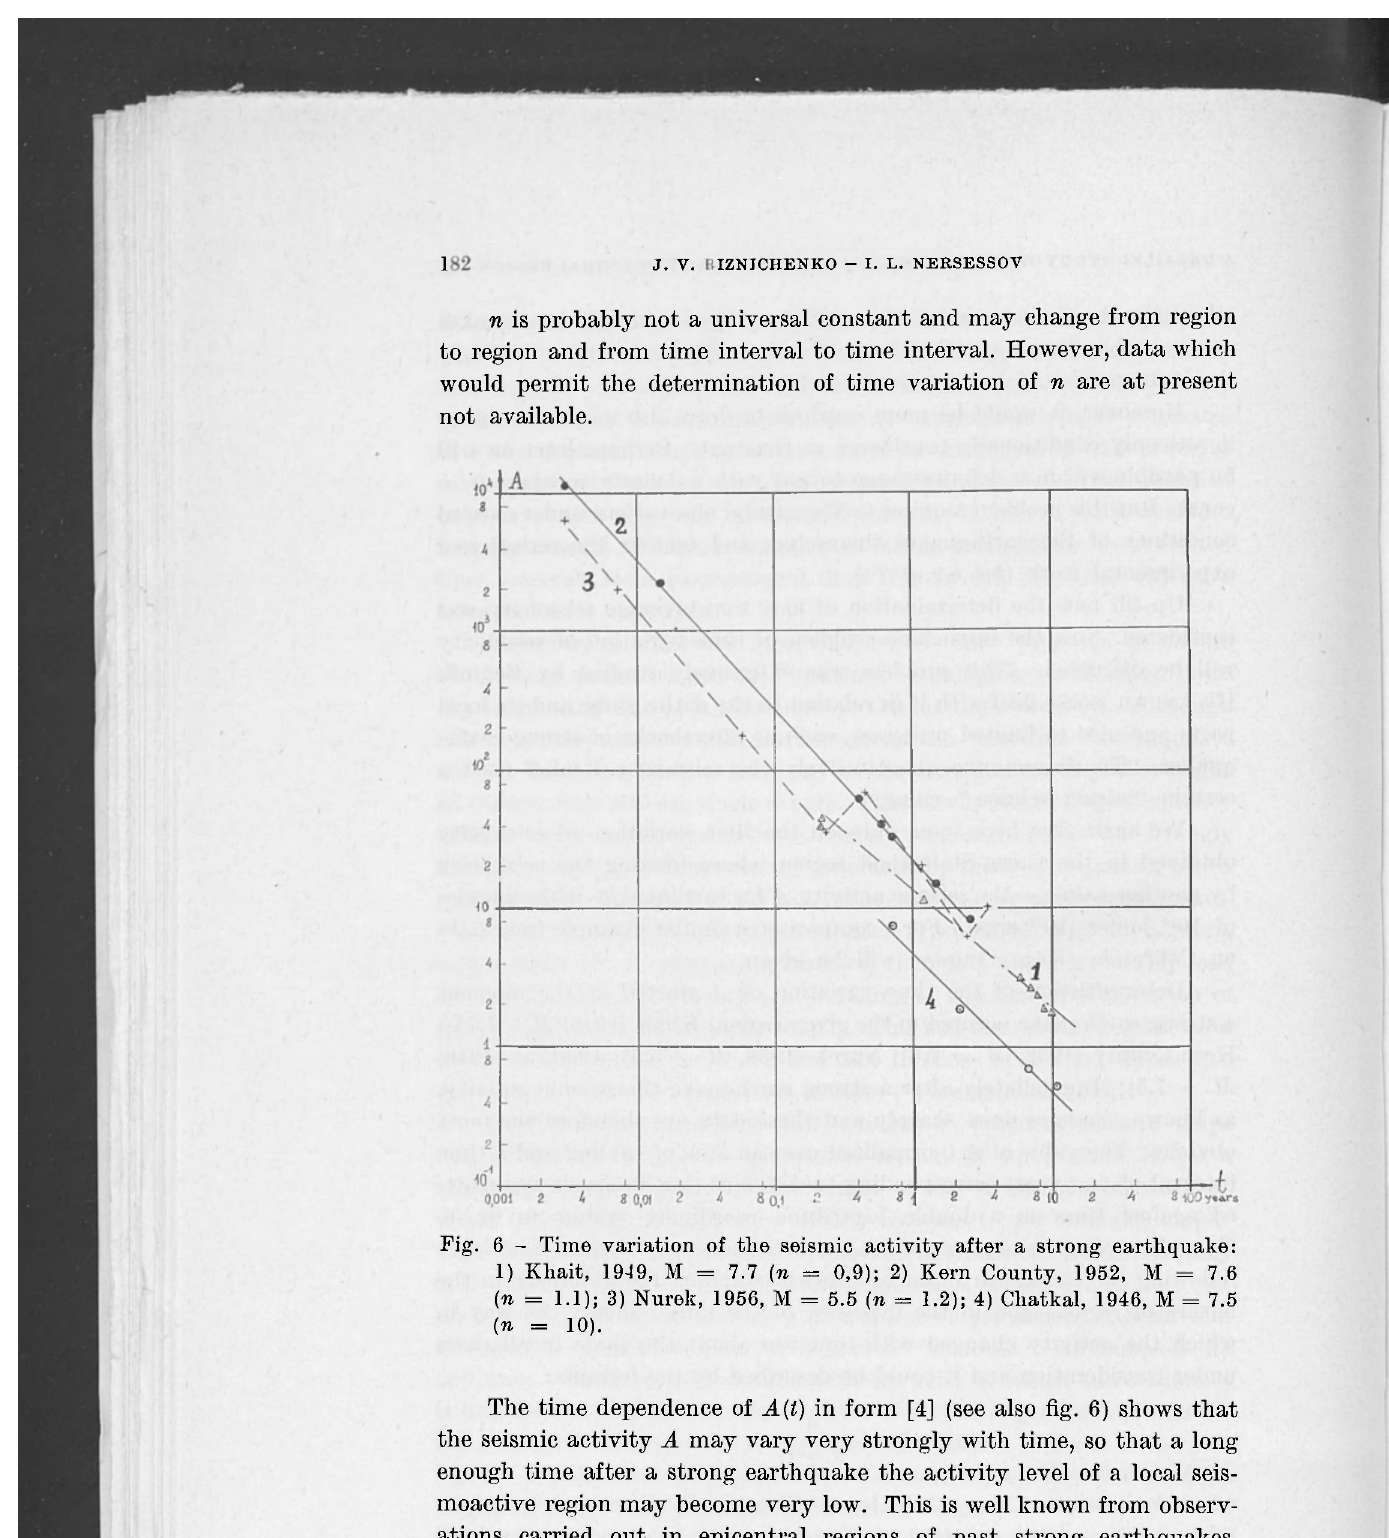
Fig. 6 - Time variation of the seismic activity after a strong